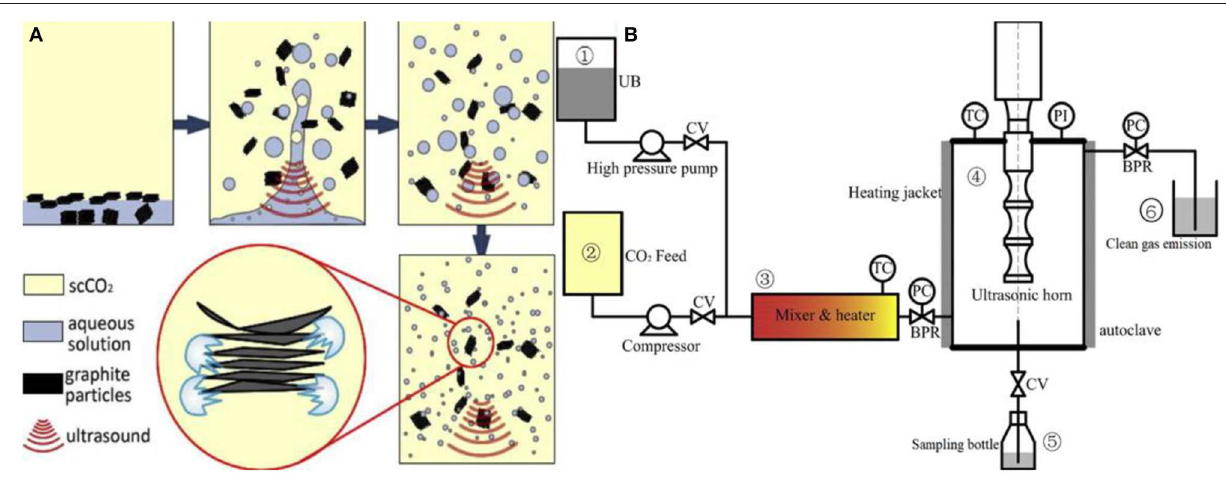
FIGURE 2 | (A) The scCO 2 , aqueous solution, and graphite particle state are distributed before and after the ultrasonic wave is applied to the system. (B) Pilot plant for the large-scale production of graphene in scCO 2 /polyvinylpyrrolidone (PVP)/H 2 O systems by ultrasonic-assisted stripping of natural graphite (where UB is the ultrasonic bath, TC is the temperature controller, PI is the pressure indicator, and PC is pressure controller; BPR is the back-pressure regulator and CV is the check valve; ‹ is the raw material supply system, › is the CO 2 feeding system, fi is the heating/mixing system, fl is the ultrasonic coupling supercritical reactor, (cid:176) is the product collector, and – is the exhaust gas